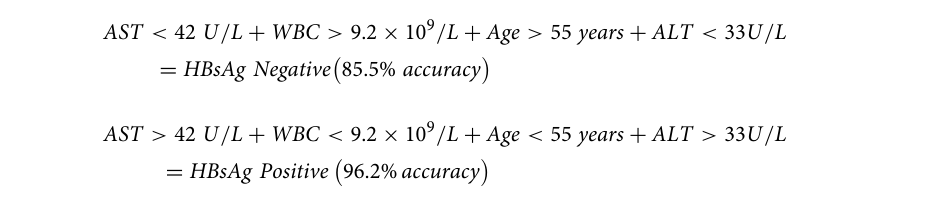
Figure 1. Kinetics for HBsAg positive (green) and HBsAg negative (red) cohorts across the age range investigated by SVM and tree-based machine learning algorithms. Comparison of mean WBC ( A ) and ALB ( B ) versus age at the time of